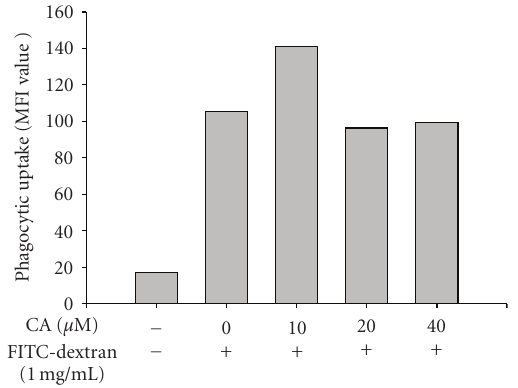
Figure 5: E ff ect of CA on the phagocytic uptake of FITC-labeled dextran. RAW264.7 cells (1 × 10 6 ) were incubated with CA in the presence or absence of 1mg/ml of FITC-labeled dextran for 30min. The uptake level of dextran was determined by flow cytometric